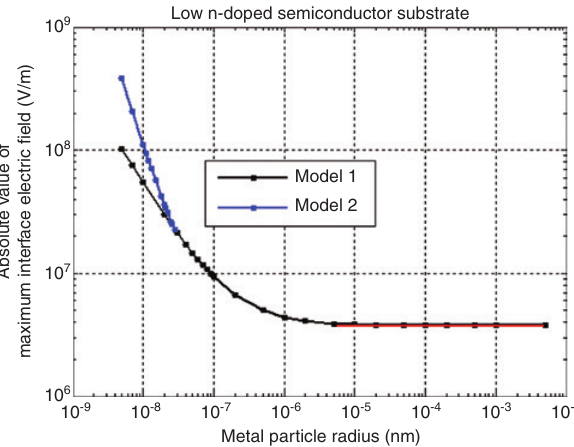
Figure 4: The effect of having high surface charge density on nanometal particle to the reduction in the depletion width over Figure 5: A schematic showing the maximum electric field at the M-S interface for a low n-doped substrate when the metal particle the planar value, which results in an improvement of the potential radius increases. energy at the interface to a maximum value as φ on